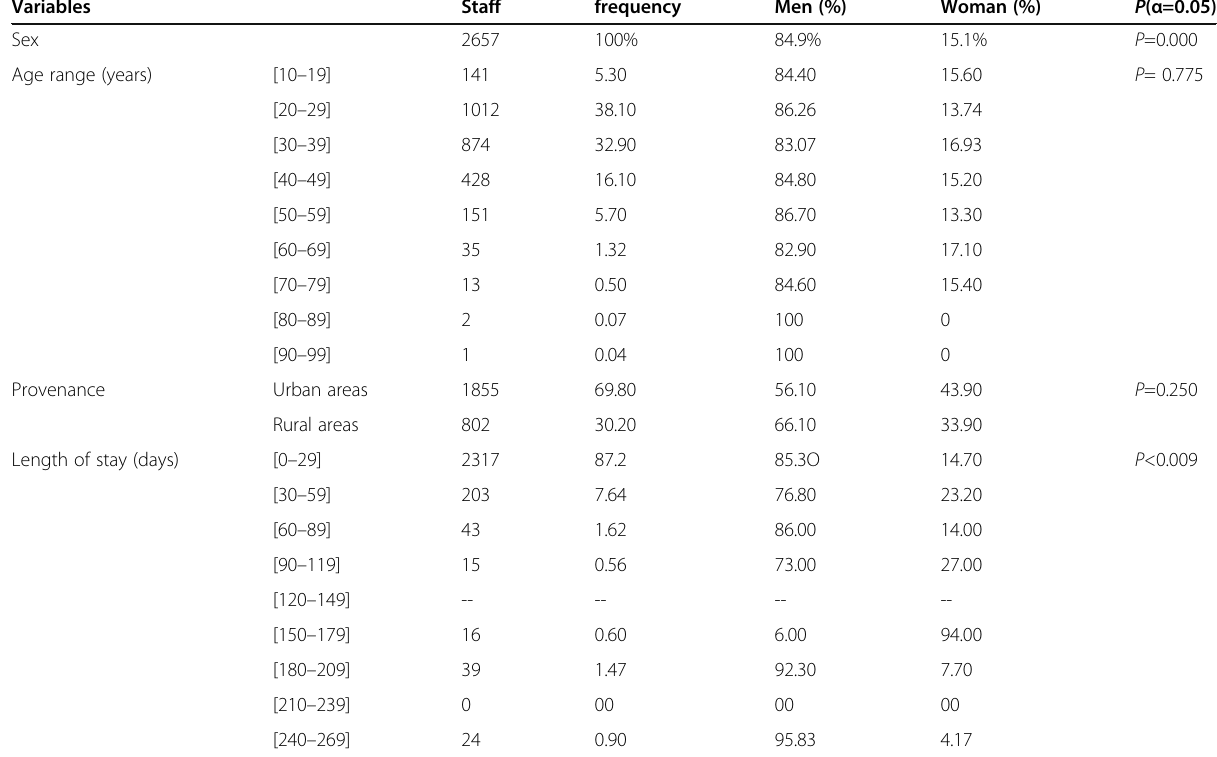
Table 2 Characteristics of the schizophrenic sample in the study area Variables Staff frequency